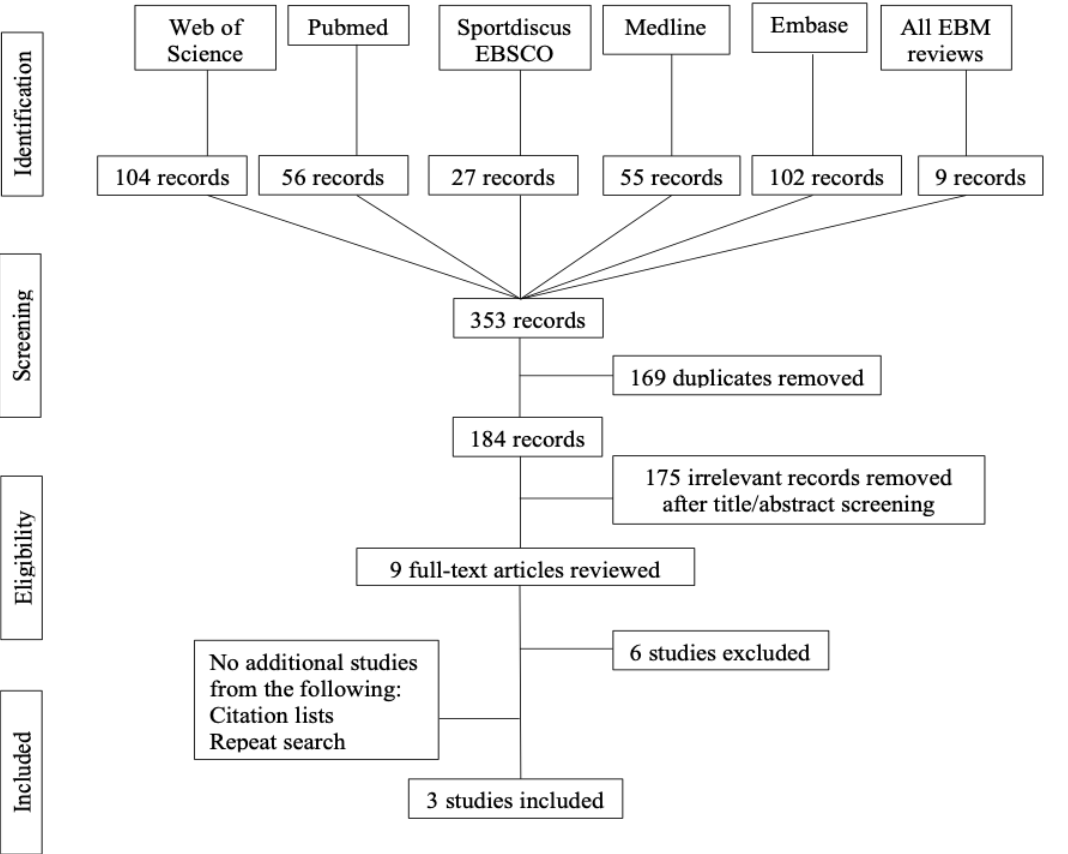
Figure 1. PRISMA flow chart.